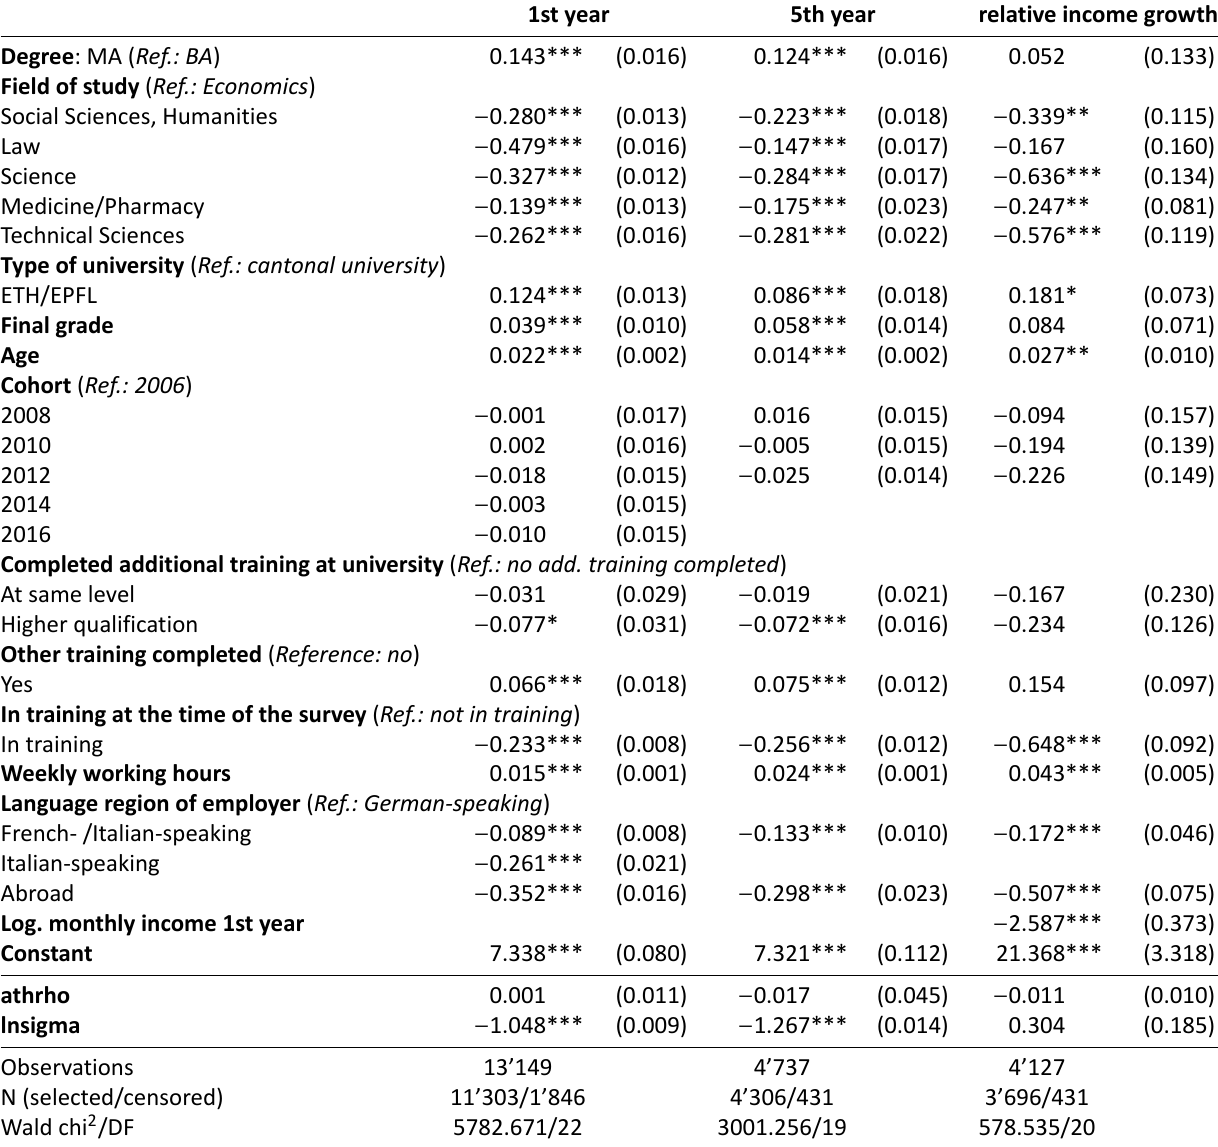
Table 1. Men’s monthly income (log.) in the first and fifth year after graduation and their relative income